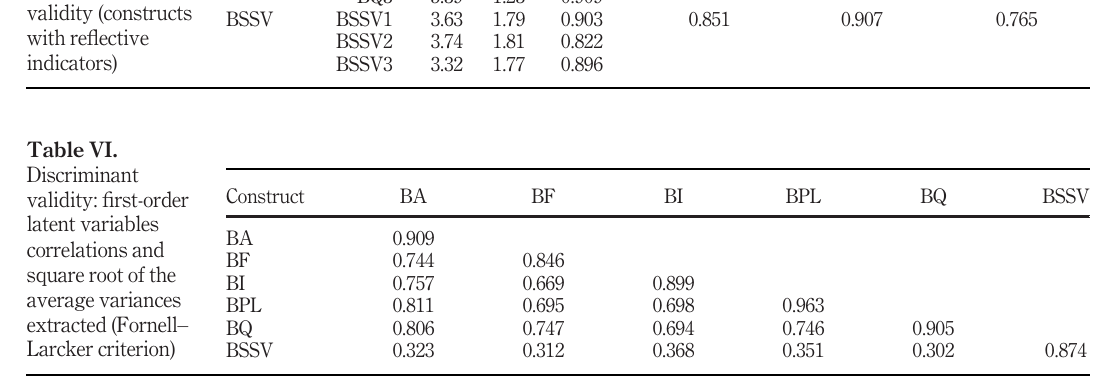
and convergent validity (constructs with re fl